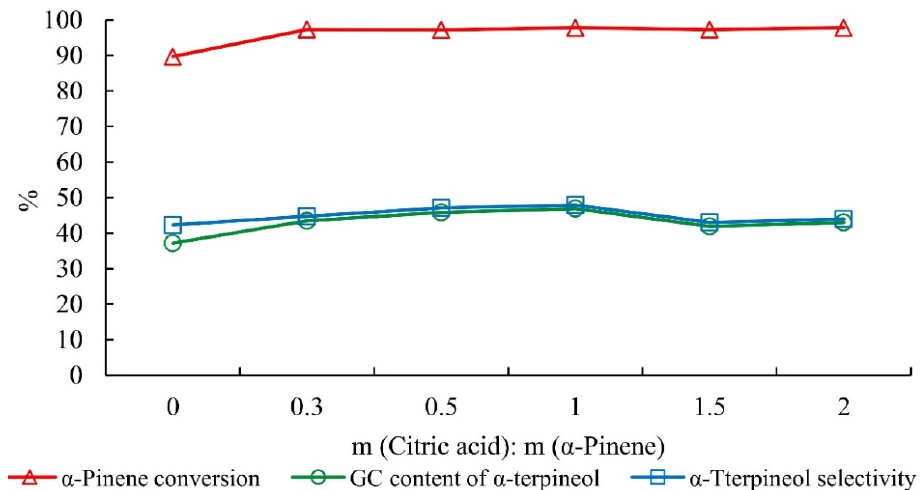
Figure 7. Influence of citric acid dosage on the hydration of alpha-pinene. Note: The mass ratio of alpha-pinene, water, acetic acid, and phosphoric acid was 1:1:2.5:0.05 for 5 h.